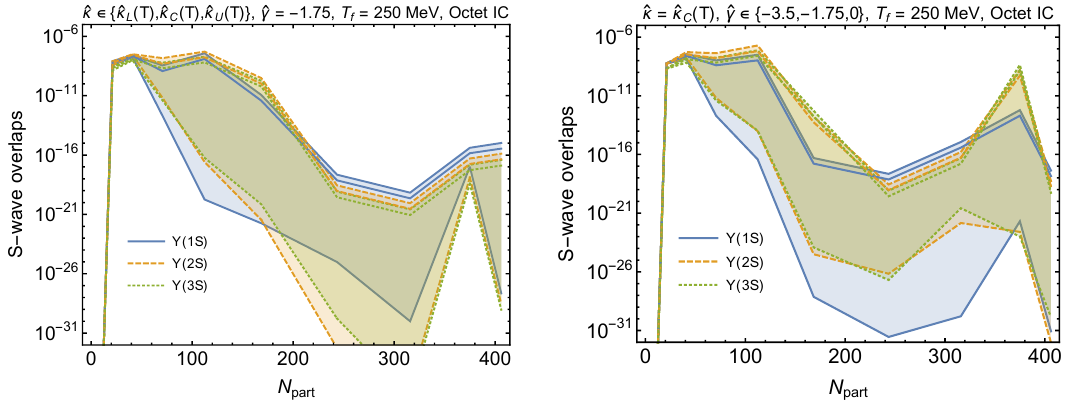
Figure 14 . Quantum-mechanical overlaps with singlet P -wave states obtained using singlet S -wave initial conditions. The bands shown in the left and right panels correspond to the variations detailed in the caption of figure 6. In both panels, the central line shows the result averaged over the corresponding variation.